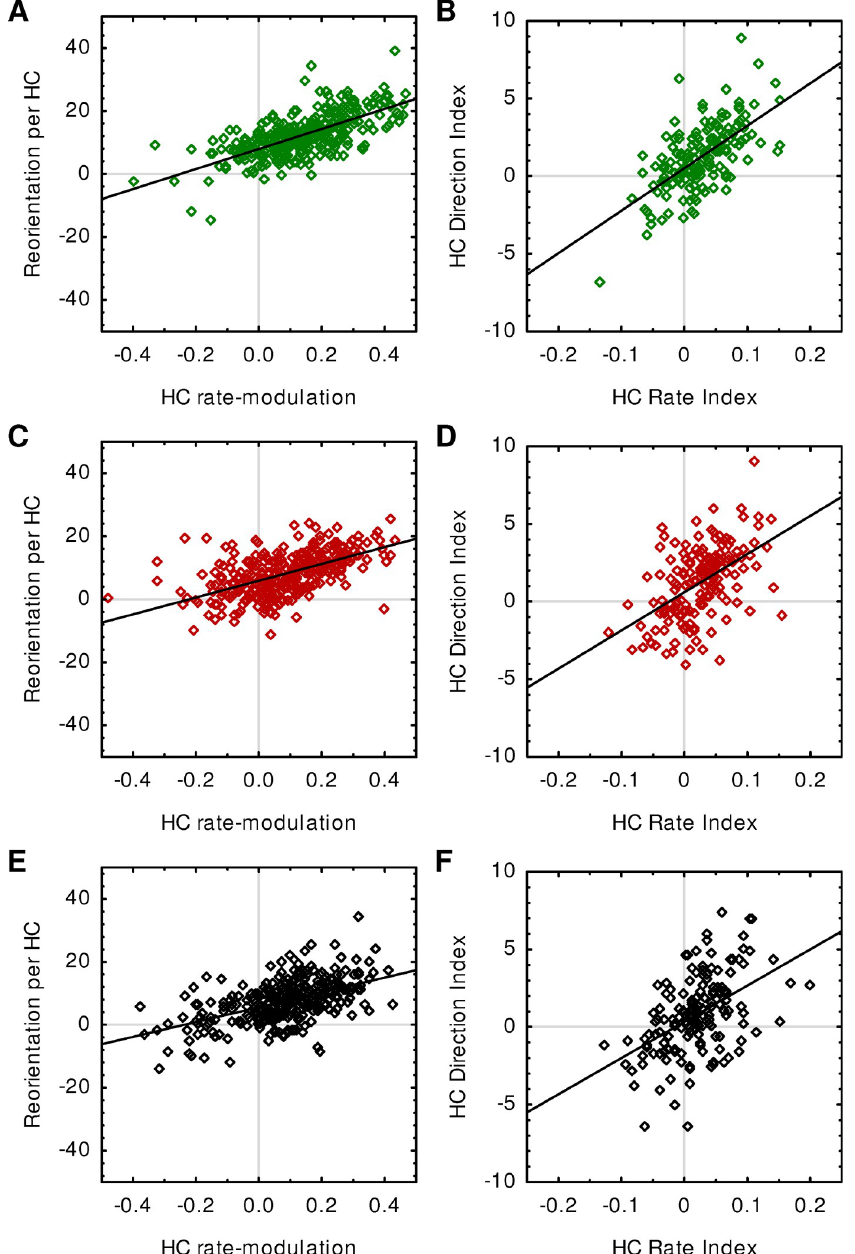
Fig 3. Modulations of HC rate and HC direction are correlated with each other. (A) For the experiment with varied sugar concentration, HC rate-modulation and Reorientation per HC are positively correlated (Spearman, r S = 0.65, p < 0.00001, N = 336). This means that a group of animals that makes many HCs while heading away from the odour and few HCs while heading towards the odour (high HC rate-modulation) also shows a strong bias to direct their HCs toward the odour source (high Reorientation per HC), and vice versa . (B) The HC Rate Index, i.e. the difference in HC rate-modulation between a group of paired-trained and a group of unpaired-trained animals, and the HC Direction Index, i.e. the difference in Reorientation per HC between a group of paired-trained and a group of unpaired-trained animals, are positively correlated with each other (Spearman, r S = 0.6, p < 0.00001, N = 166). (C-D) As in A-B but for the experiment with varied odour concentration (Spearman, [E] r S = 0.59, p < 0.00001, N = 345; [F] r S = 0.51, p < 0.00001, N = 170). (E-F) As in A-B but for the experiment with a varied number of training trials (Spearman, [G] r S = 0.55, p < 0.00001, N = 318; [H] r S = 0.48, p < 0.00001, N = 156).